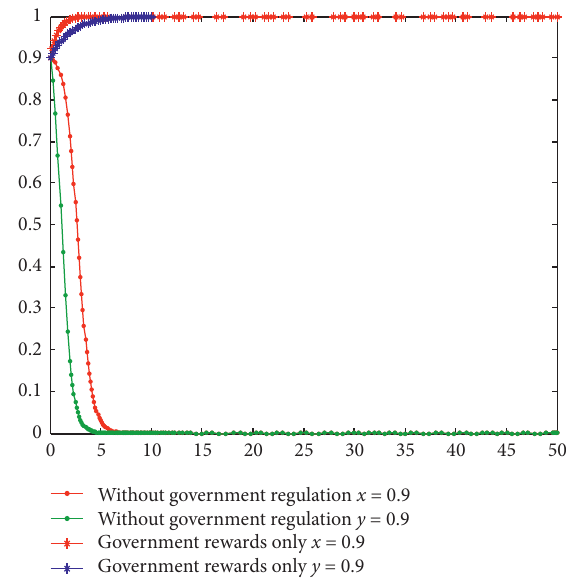
Figure 1: Influence of government subsidies on the formation of the green dairy industry chain.